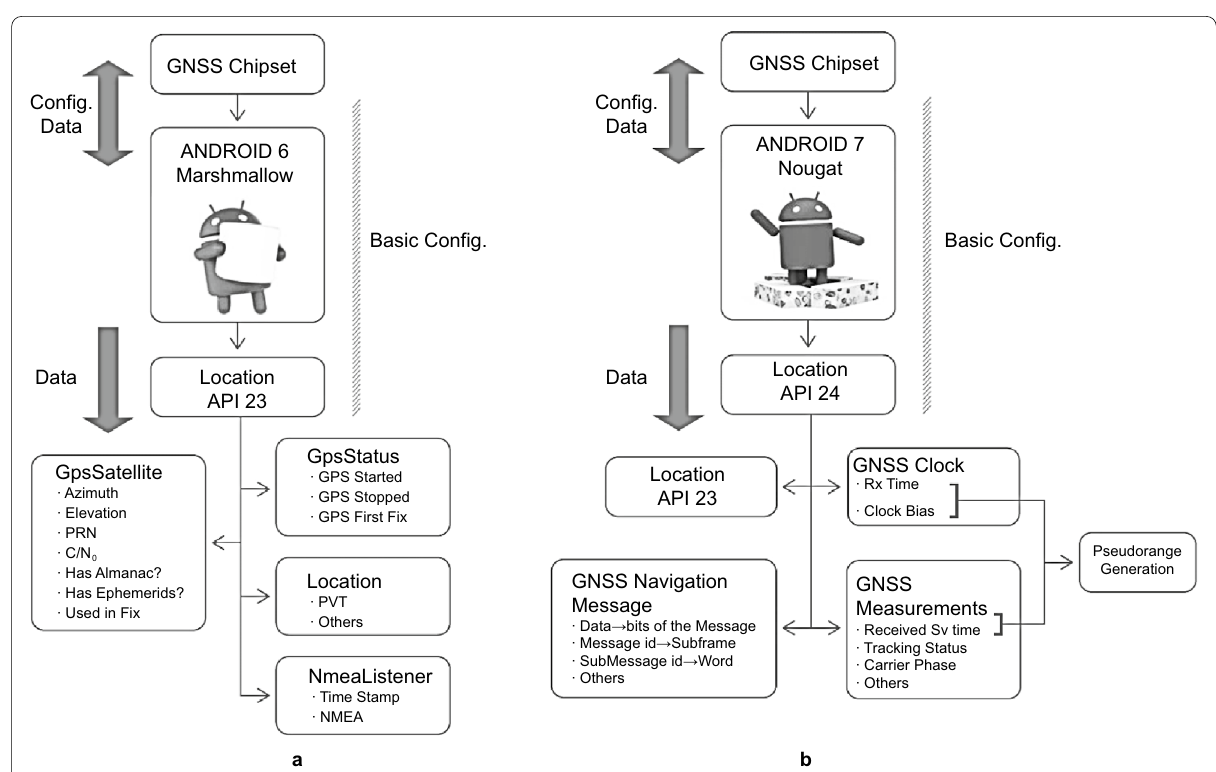
Fig. 2 Location API in a Android version 6 (Marshmallow) and b Android version 7 (Nougat) (European GSA,